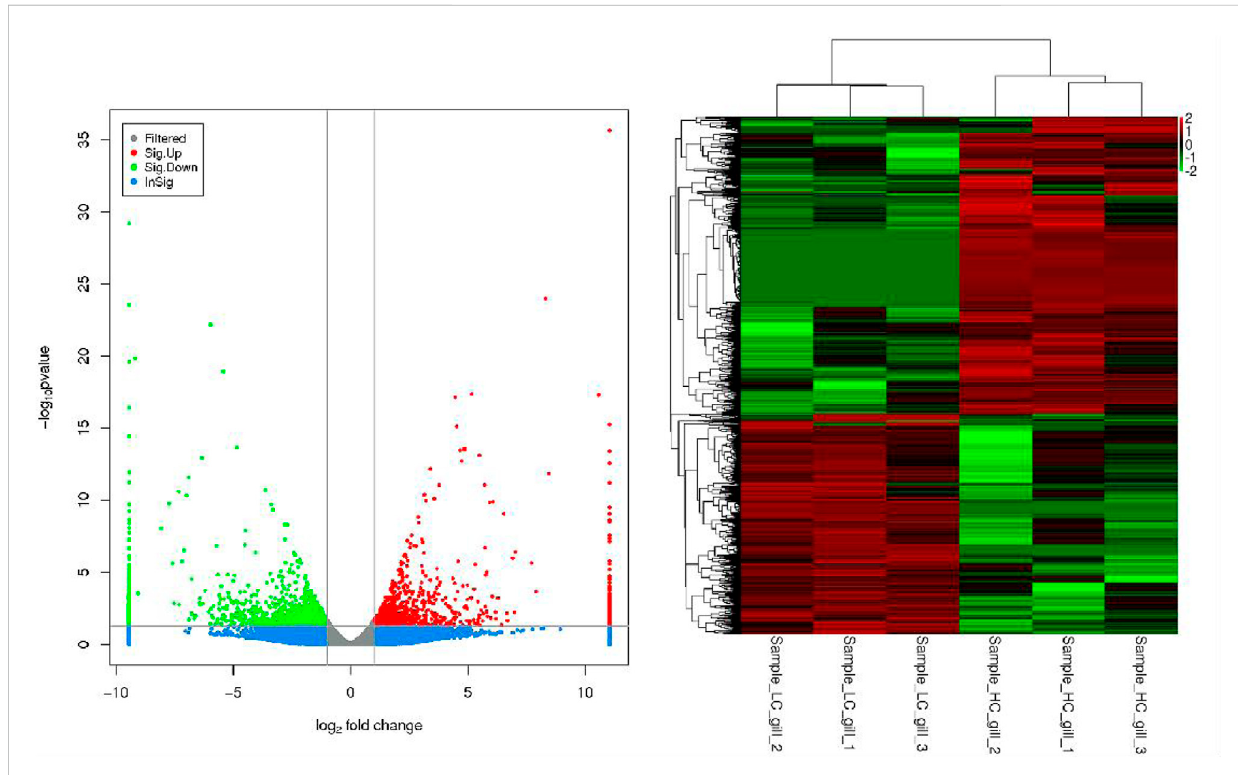
FIGURE 2 Cluster analysis results for each difference grouping (LC vs.